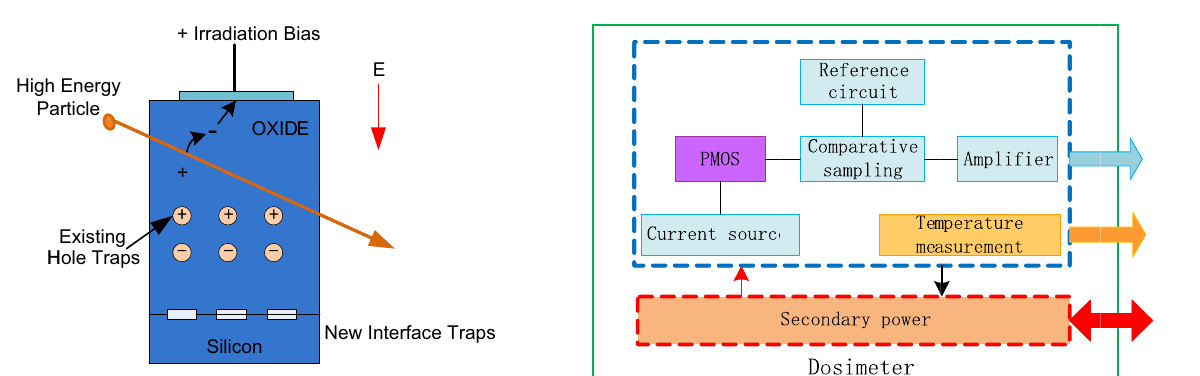
Figure 4: Schematic diagram of working principle of radiation dosimeter.